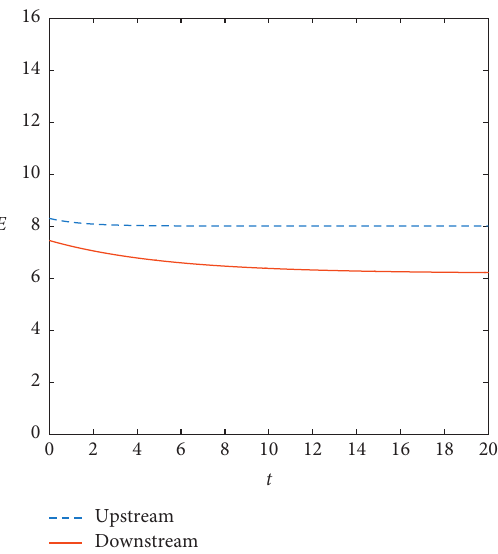
Figure 4: Optimal trajectory of pollution emission under non- cooperation when T ⟶ ∞